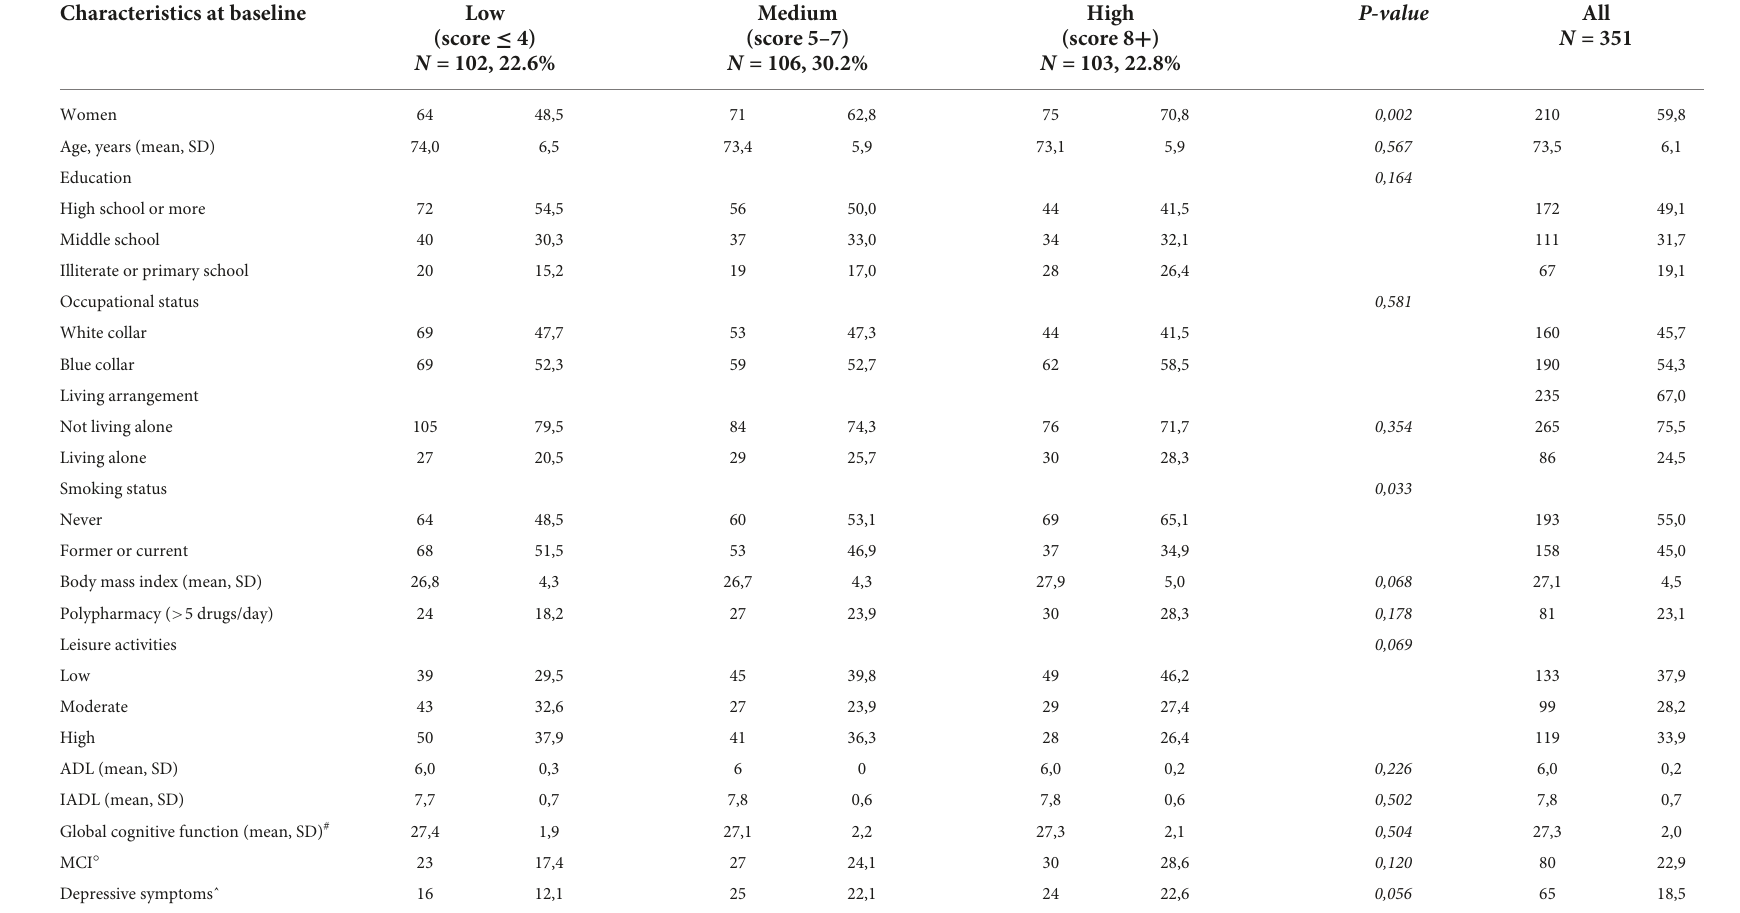
TABLE 1 Baseline characteristics of participants by tertiles of fear score (N =